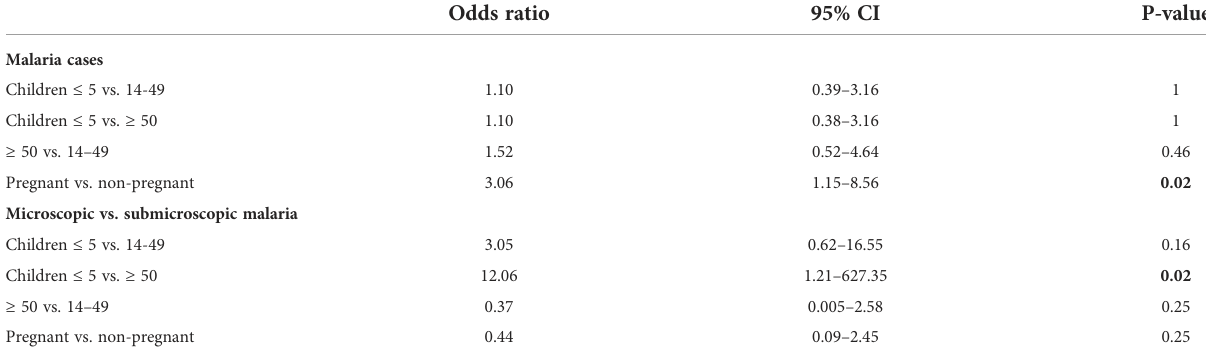
Bold values indicates signi fi cant p-values ( ≤